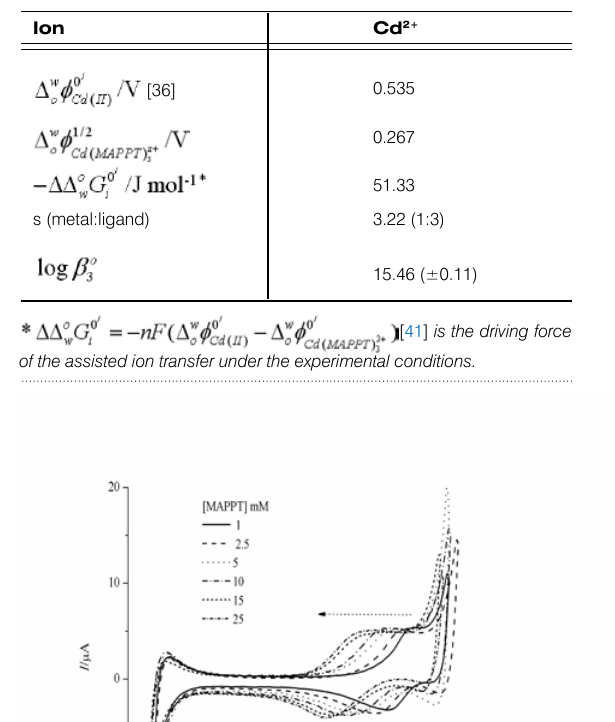
Table 1. Thermodynamic parameters of Cd 2+ ion transfer assisted